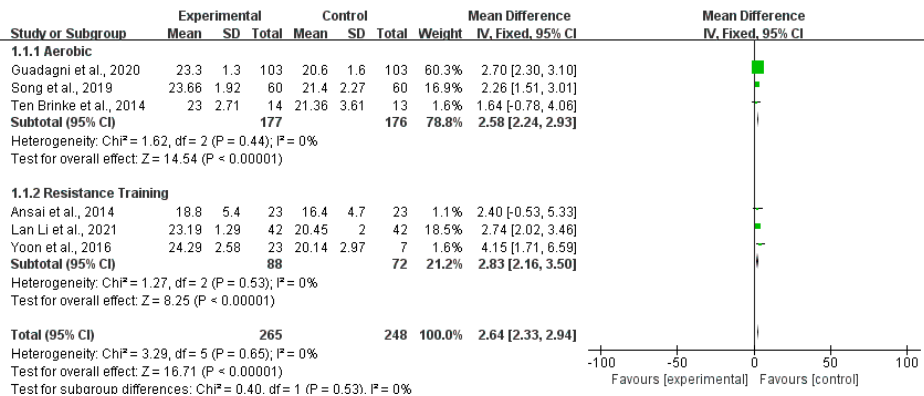
Figure 4. Forest plots of MoCA scale outcomes in overall analysis [15,19,20,22,26,30].